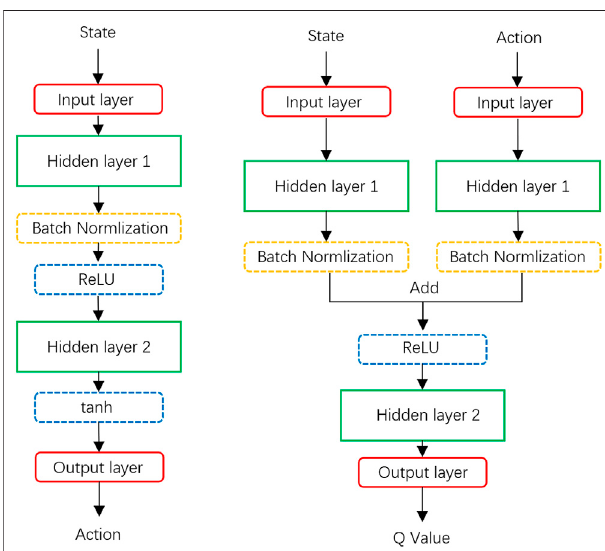
FIGURE 3 | DNN framework for the actor network and critic network.